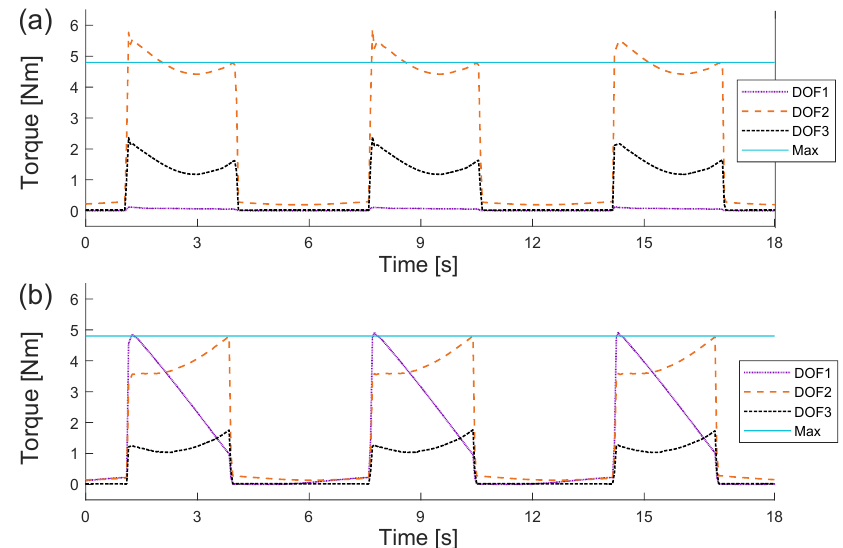
Figure 13. The motors’ torque during gait cycles for both ( a ) template and ( b ) anchor morphology.